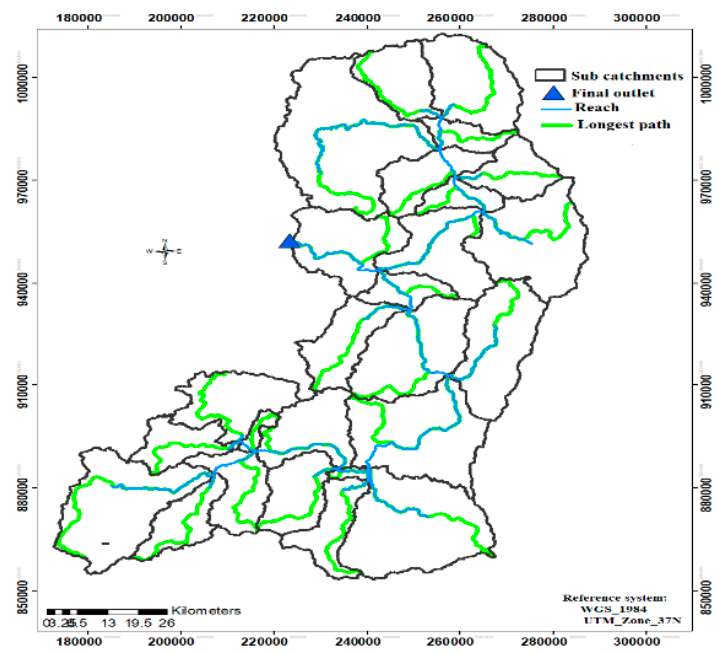
Figure 5. Didessa river basin with the final outlet point near Arjo town.